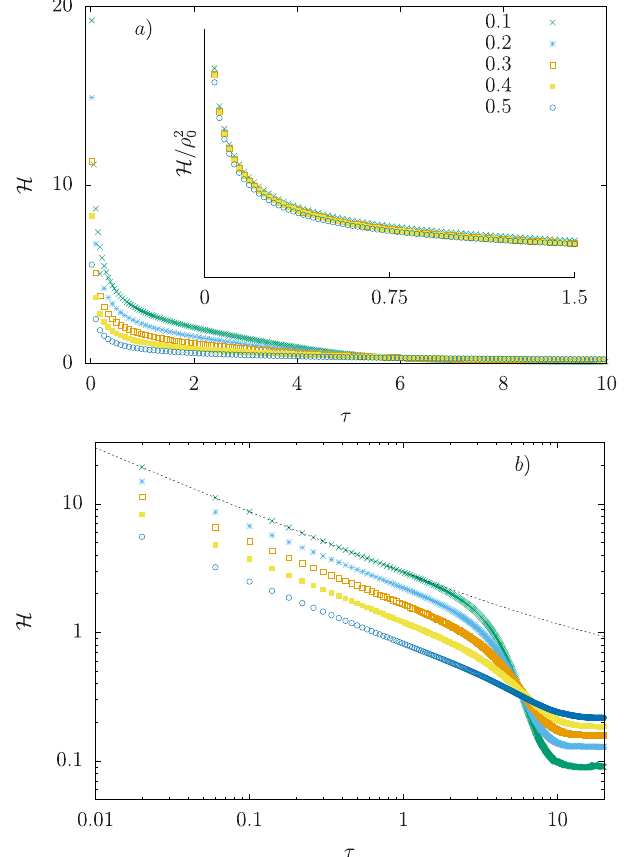
Figure 2. Finite size effects on the Hamiltonian. ( a ) Simulated data with N = 50 and 10 6 Monte Carlo runs for various ratios γ / α . (inset) Data collapse using the scaling factor ρ 02 , suggesting an universal behavior at the beginning of the outbreak. ( b ) Initial decay of  compatible with power-law, ~  τ λ − . The exponent λ = 1/2 remains constant for different ratios γ / α , suggesting an universal